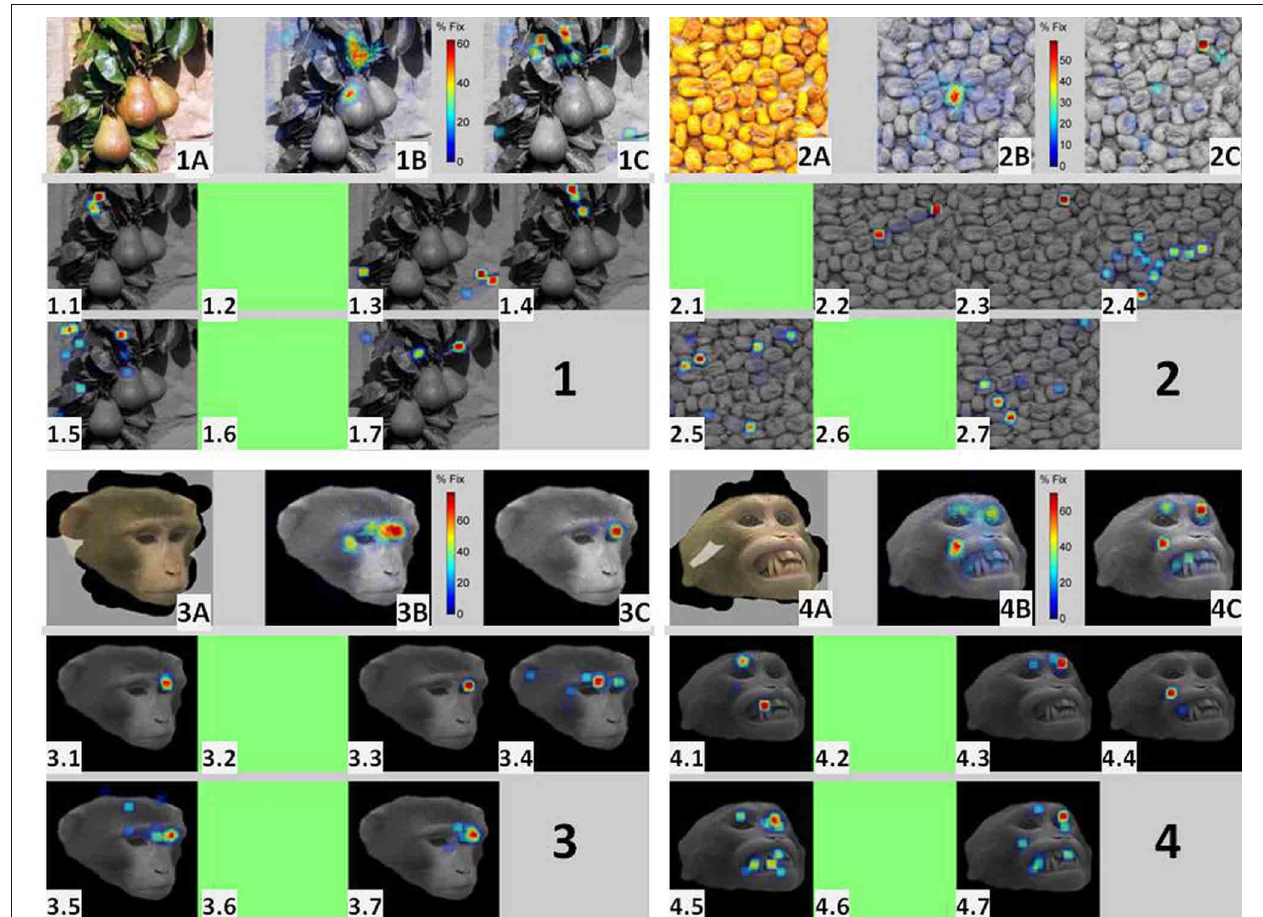
FIGURE 5 | Ensemble bursting in the amygdala of primates as a neural mechanism to signal saliency: the figure is divided into four panels, each summarizing the behavioral (eye movements) and electrophysiological responses to repeated presentations of four different images (two faces and two non-faces) within a single session. Each one of the four images was presented a minimum of 20 times (in pseudo-random order) for 3s. Within each panel, the upper leftmost insets ( 1A, 2A, 3A, 4A ) depict the masked image obtained by veiling (in gray) pixels that were never visited by the eyes during the repeated presentations of the same image. The middle